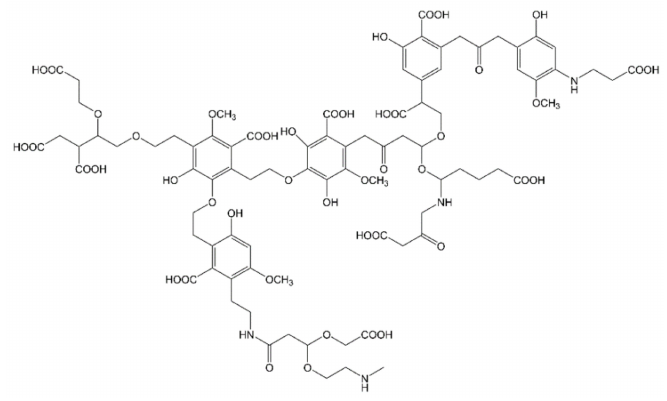
Figure 2. HS molecular fragment, inspired by Deganello et al.